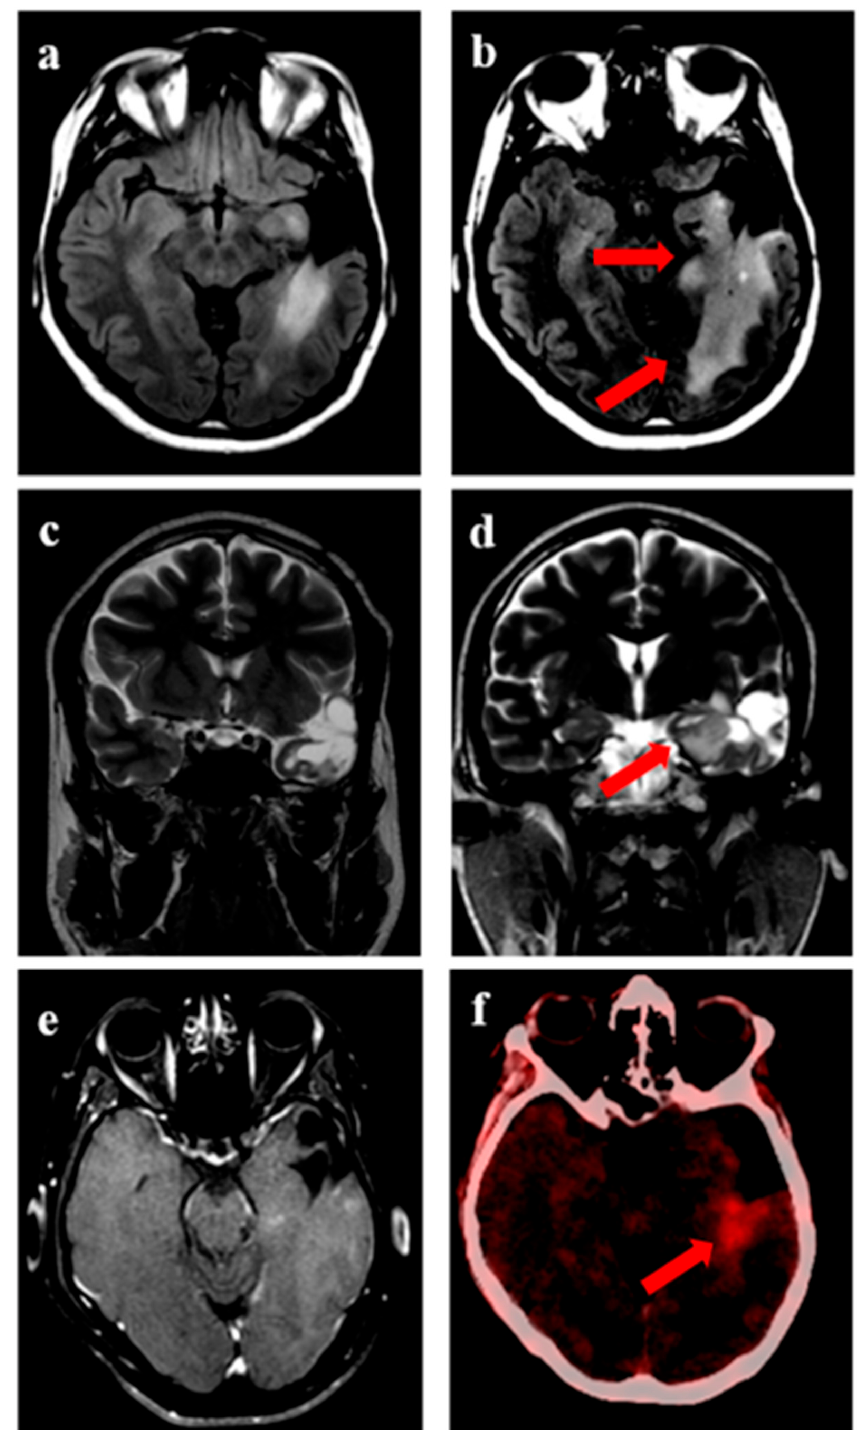
Figure 1. Progression-free survival ( a ) and overall survival ( b ) following re-irradiation in high-grade glioma.